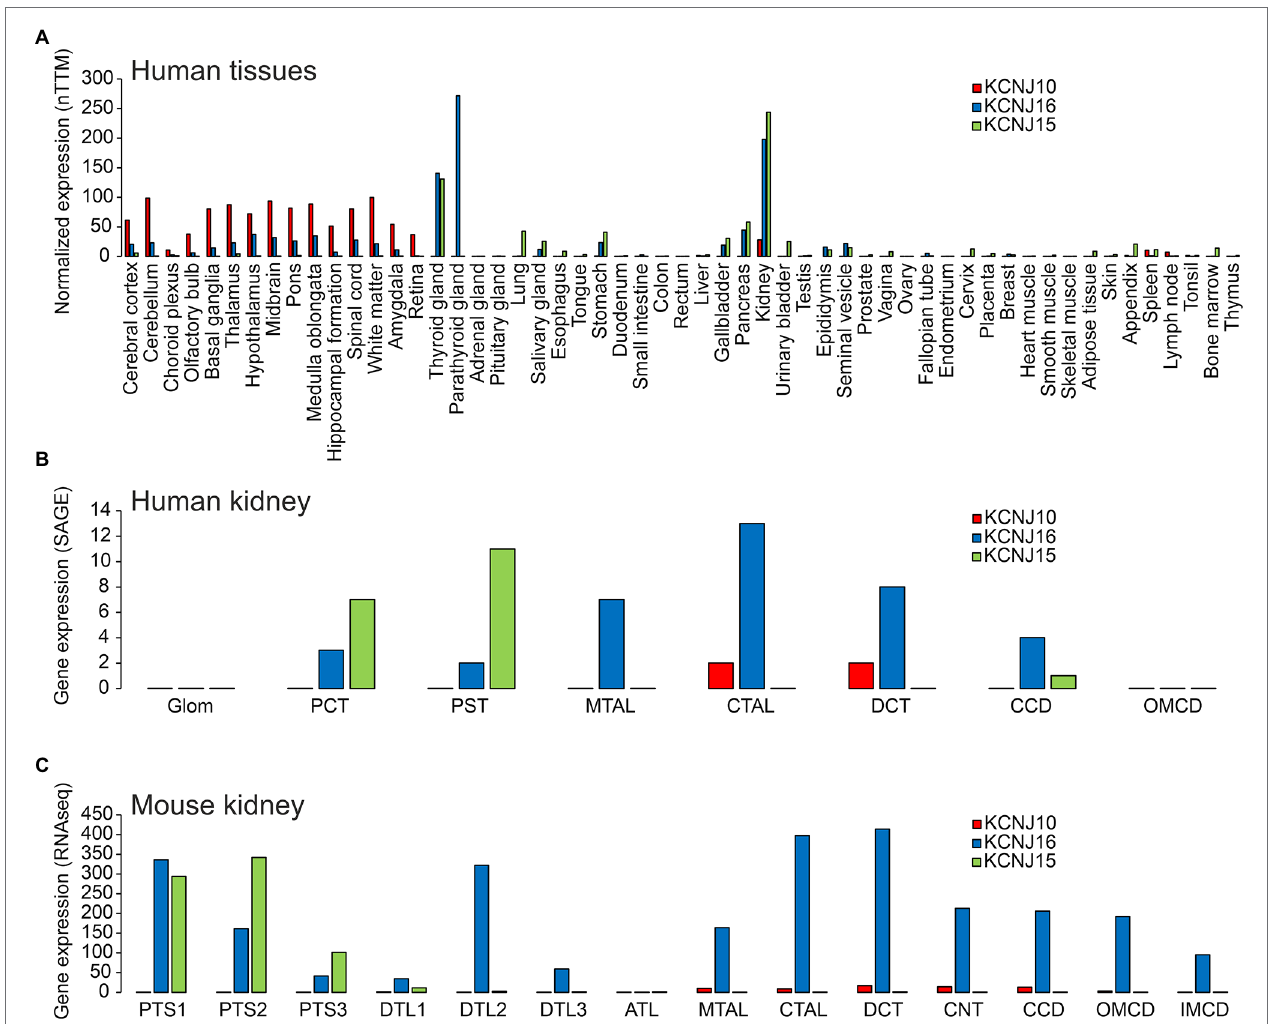
FIGURE 2 | (A) Expression of KCNJ10 (Kir4.1), KCNJ16 (Kir5.1), and KCNJ15 (Kir4.2) in human tissues. Data were obtained from “The Human Protein Atlas” (https://www.proteinatlas.org/ENSG00000177807-KCNJ10/summary/rna; https://www.proteinatlas.org/ENSG00000153822-KCNJ16/summary/rna;